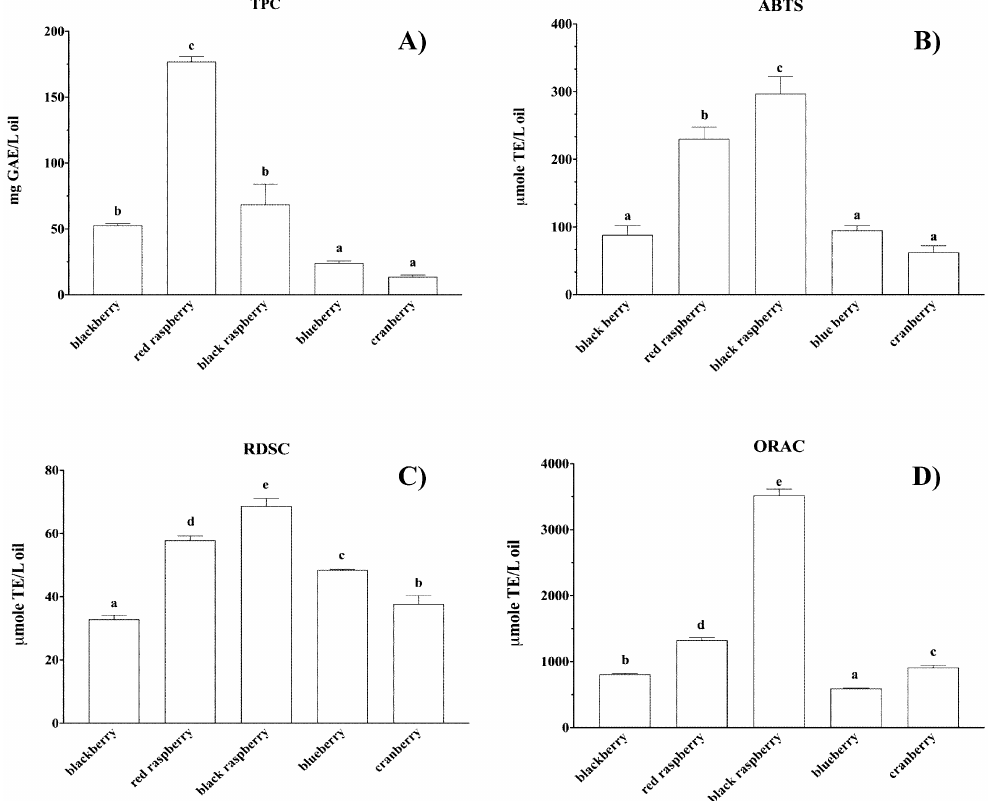
Figure 5. ( A ) Total phenolic content (TPC), ( B ) ABTS radical cation scavenging capacity, ( C ) relative DPPH radical scavenging capacity (RDSC), and ( D ) oxygen radical absorbance capacity (ORAC) of the blackberry, red raspberry, black raspberry, blueberry and cranberry seed oil extracts. Different letters represent significant differences within a column ( p <